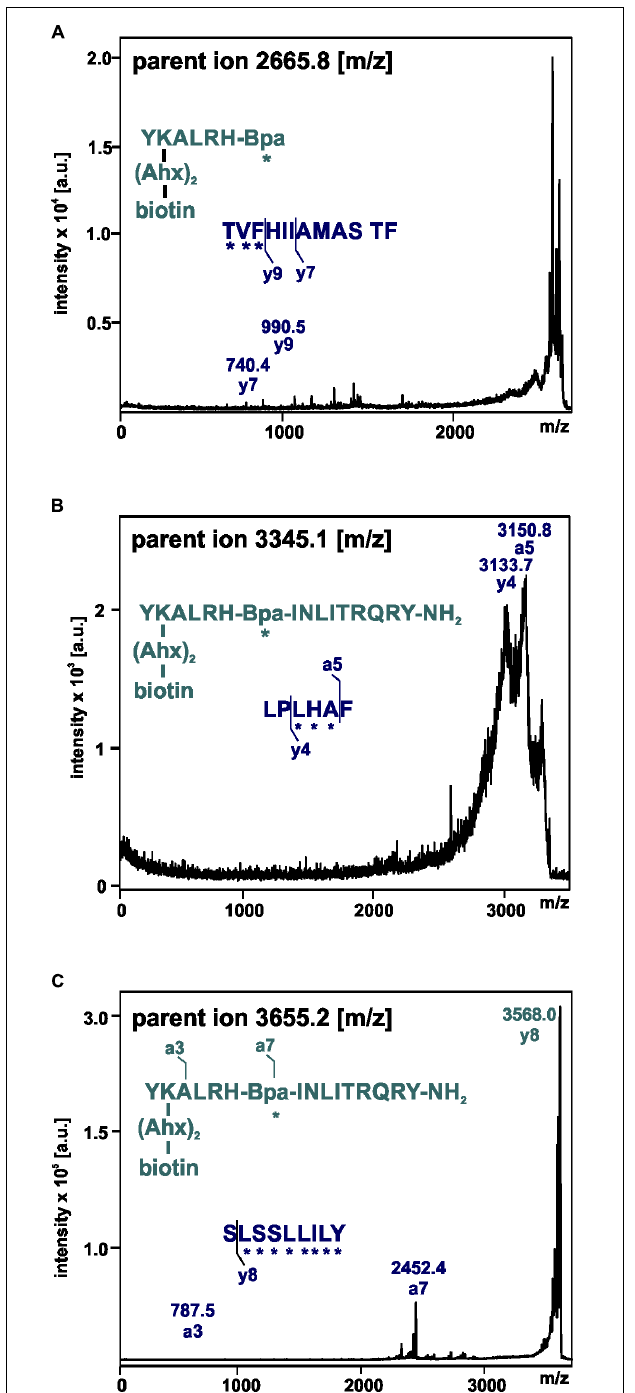
FIGURE 7 | Mass spectra of MS/MS analysis of the signals m/z 2665.8 (A) , 3345.1 (B) , and 3655.2 (C) resulting from photo-crosslinked Y 2 R_cysteine_deficient with [K 22 [(Ahx) 2 -biotin]Bpa 27 ]NPY. Amino acid sequences of the identified regions in Y 2 R_cysteine_deficient (blue) and [K 22 [(Ahx) 2 -biotin]Bpa 27 ]NPY (cyan) are depicted with the fragmentation sites resulting from collision induced dissociation (y) or electron detachment dissociation (a). Mass spectra were analyzed using Biotools 2.2. ∗ potential site of photo-crosslinking.